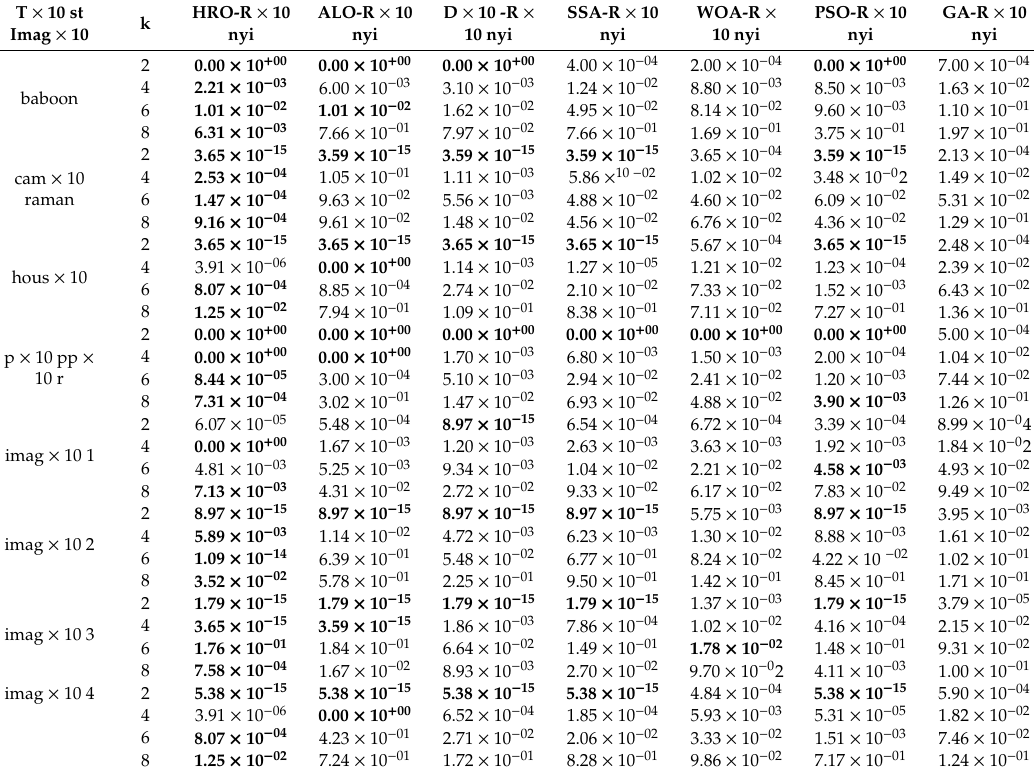
Table 3. STD of each algorithm under Renyi’s